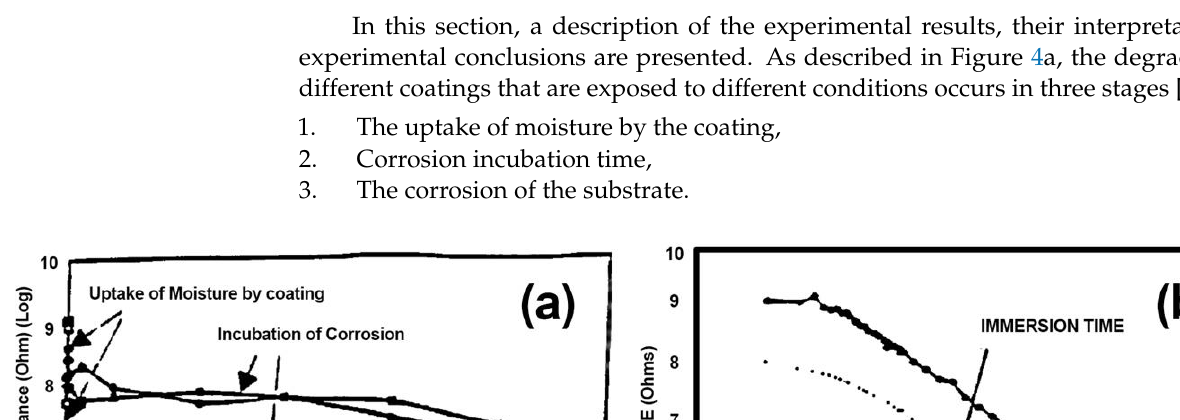
Figure 5. ( a ) An illustration of the miniaturised coating health monitor with tape electrodes. ( b ) A comparison to a conventional flat cell for EIS measurements [78].